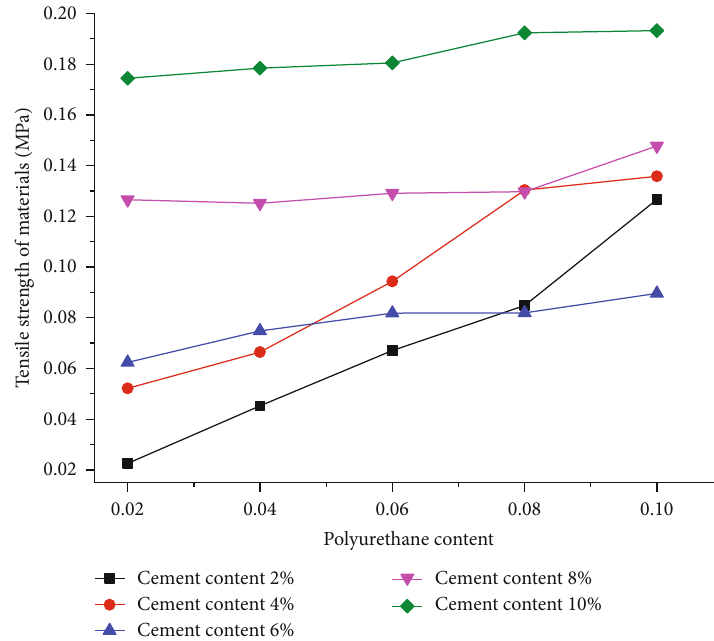
Figure 7: E ff ect of cement and polyurethane content on tensile strength of